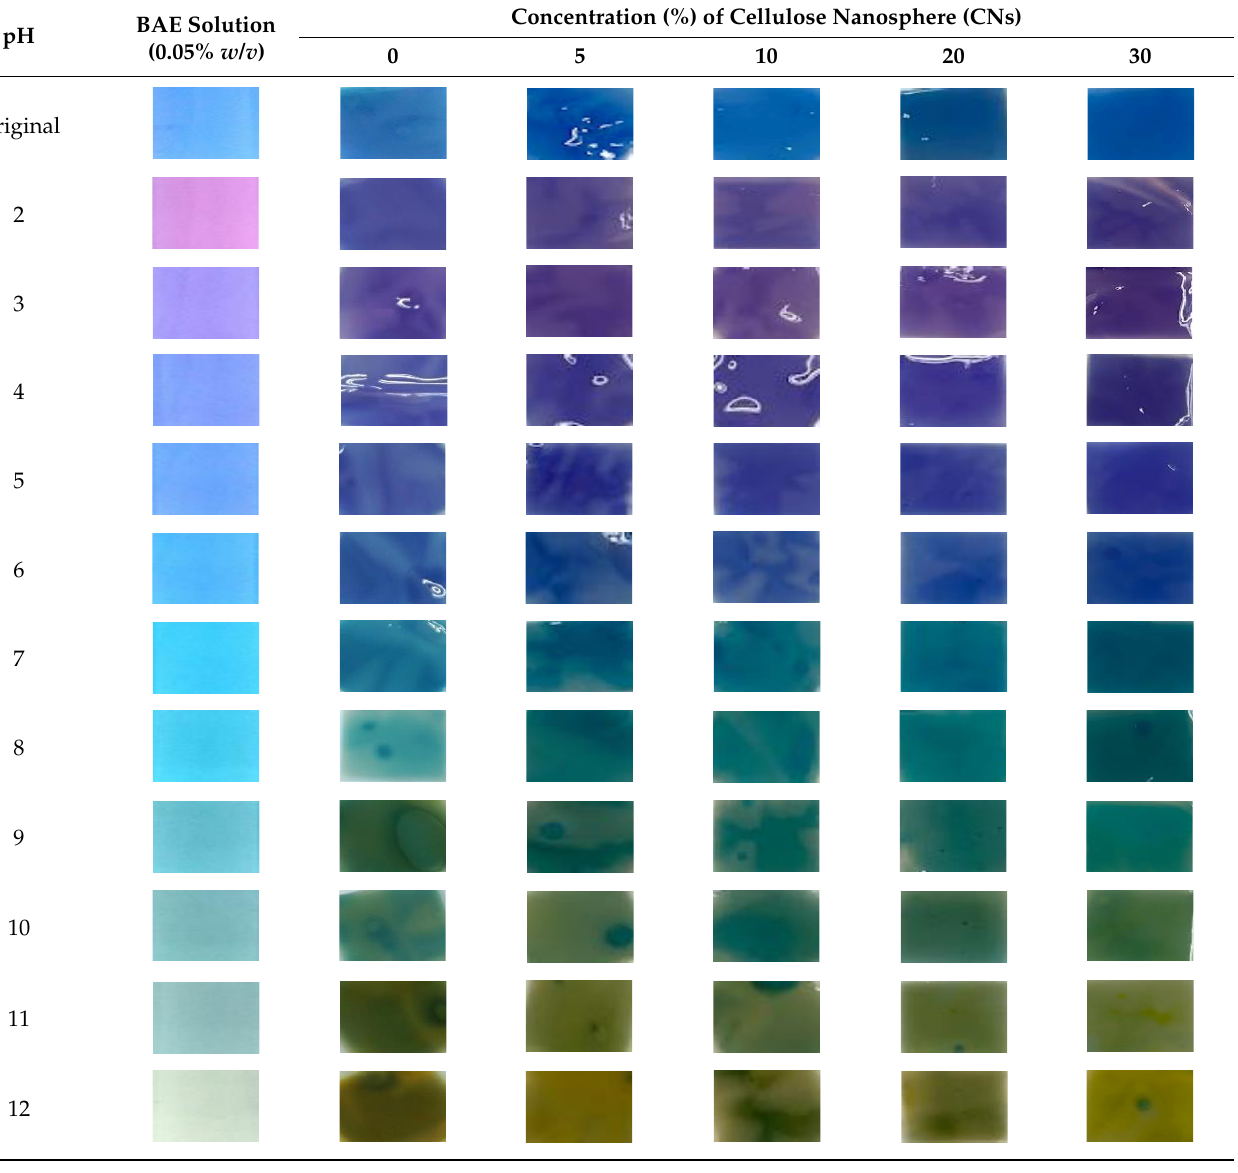
Table 4. pH sensitivity of BAE and smart bilayer film incorporated with different concentrations of cellulose nanosphere (CNs).